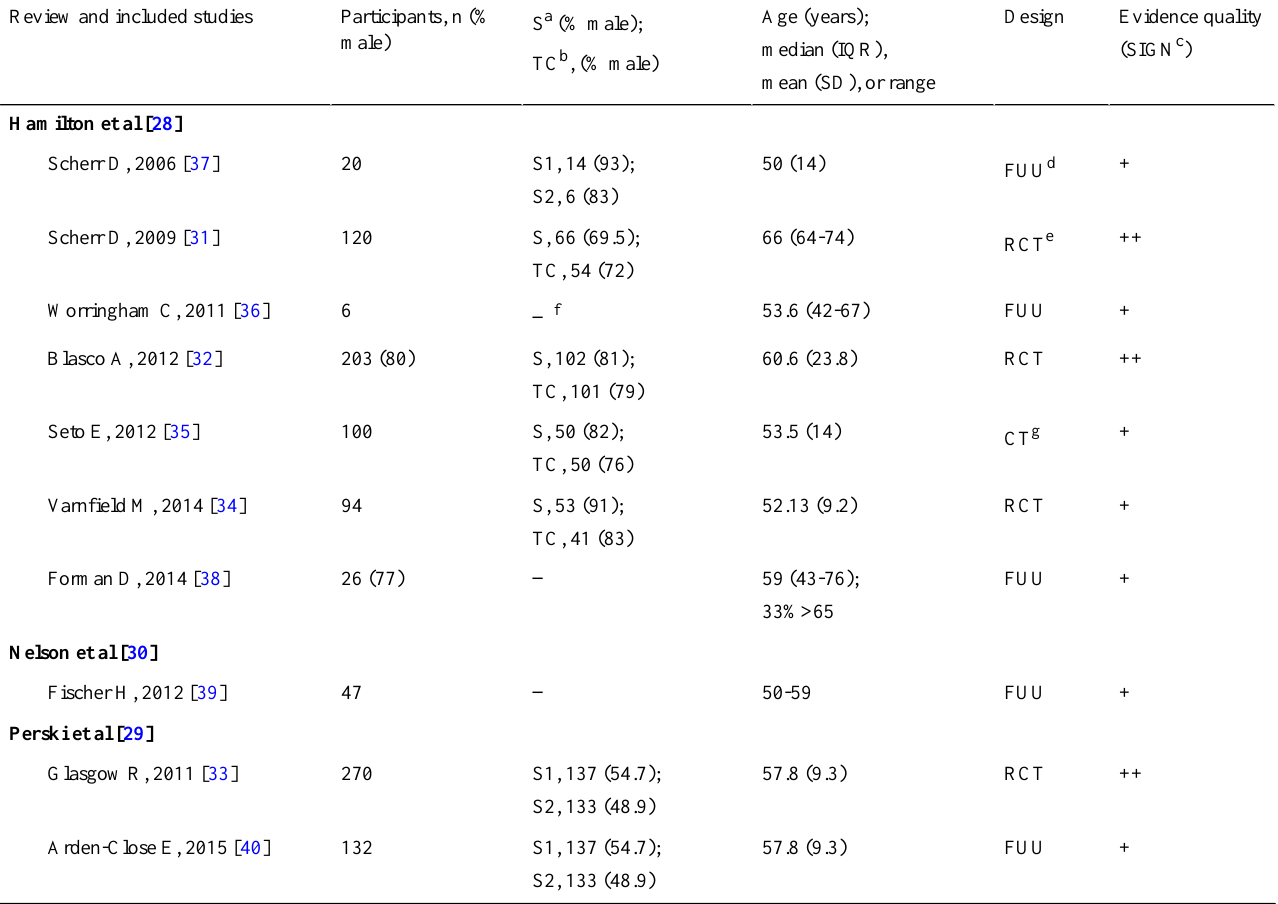
Table 2. Characteristics and design quality of included reviews.